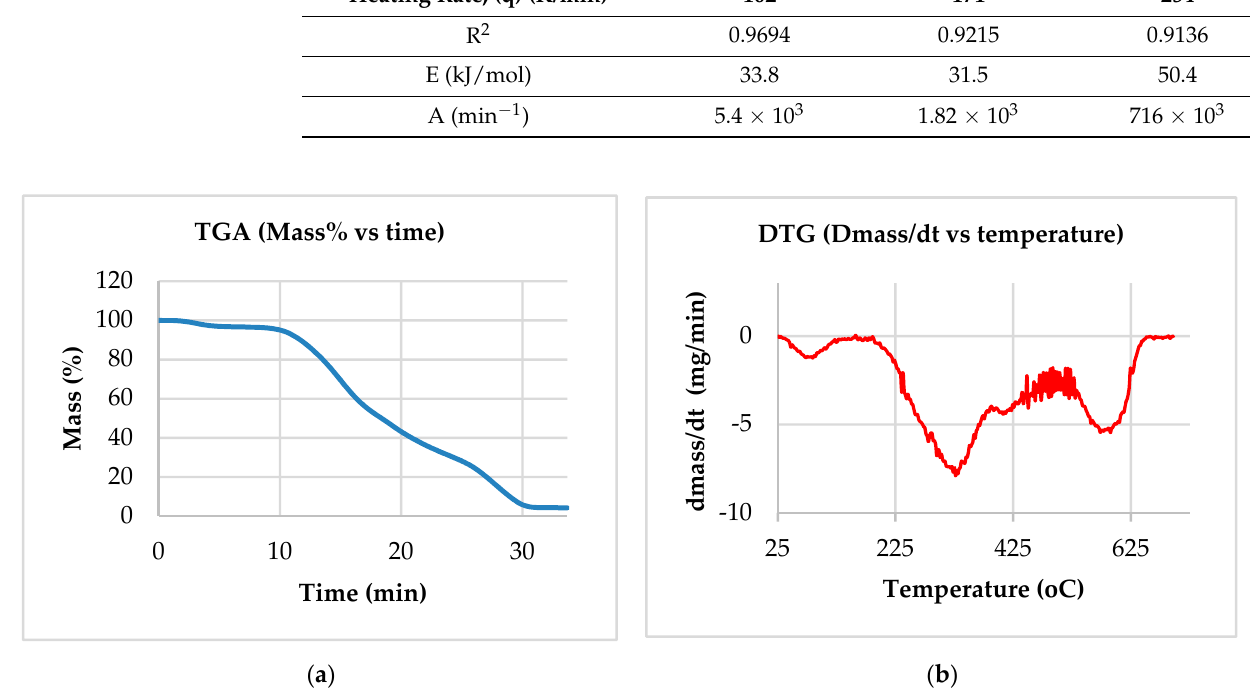
Figure 5. ( a ) Pretreated peach seeds weight loss diagram as a function of time (TGA, Air flow). ( b ) Pretreated peach seeds weight change rate diagram as a function of temperature (DTG, Air flow).